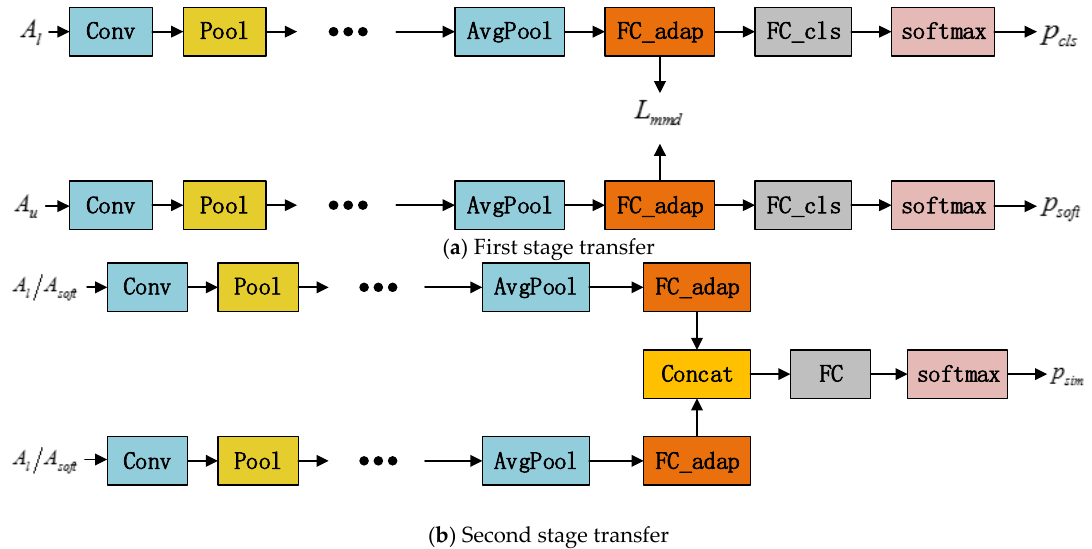
Figure 5. Transfer learning in two stages. ( a ) First stage transfer: fine-tuning with an adaptive fully connected layer. ( b ) Second stage transfer: knowledge transfer with soft labels for joint learning. In the first stage, the network is fine-tuned by the labeled image while predicting the soft labels for the unlabeled image. In the second stage, the network is trained by both labeled image and unlabeled image. A fully connected adaptive layer is adopted for feature transfer.